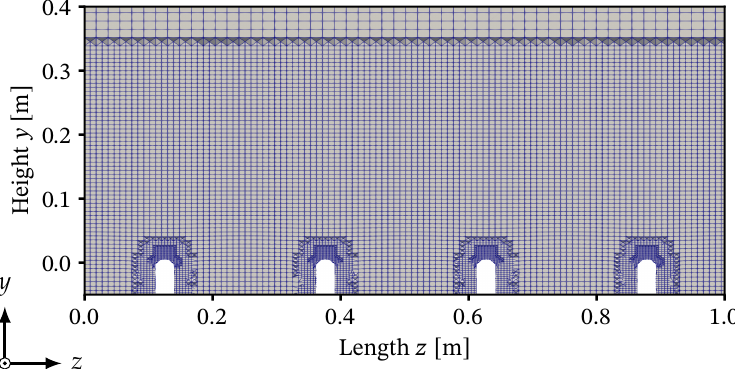
Figure 7. Cross-section of the mesh used for the simulations of the pilot-scale GF25 plant in mm. At y = 0 m, a plate was introduced on the DEM side to replicate the effect of a mesh grid that was used in the experiments. The numerical parameters and material properties are given in Table 4. The frictional parameters were chosen in analogy to Kieckhefen et al. [21]. A coarse-graining factor of δ CG = 4 was used to increase the time step to a manageable degree and reduce the number of particles to consider in order to be able to use the same particle properties in simulations of the lab-scale and pilot-scale plants. With this scaling factor, lab-scale apparatus simulations consider 155,233 parcels whereas the pilot-scale apparatus simulations consider 1,241,864 parcels. Table 4. Material properties, contact model parameters and numerical setup for the CFD-DEM models. Contact model properties were taken from [21].